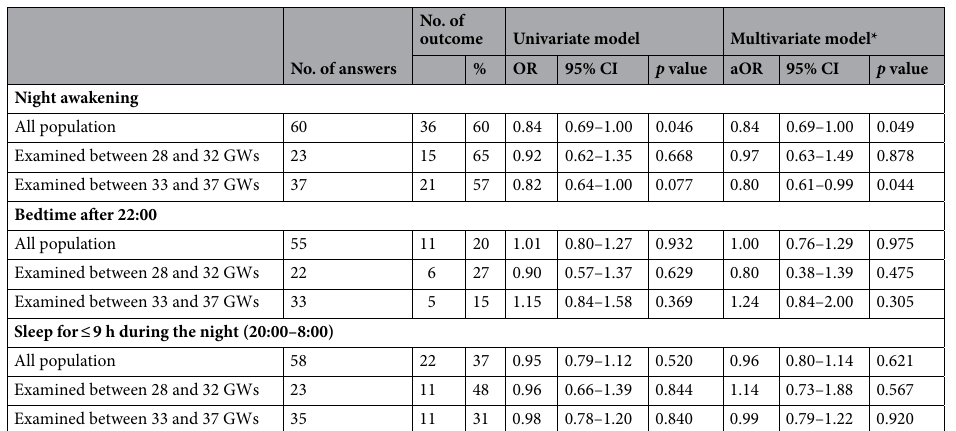
Table 2. Association between fetal EMD and infant sleep outcomes. EMD, eye movement density; OR, odds ratio; aOR, adjusted odds ratio; CI, confidence interval; GWs, gestational weeks. *Adjusted for maternal age at delivery, parity, and child’s birth weight. **All ORs or aORs are per 1/min increasing fetal EMD.